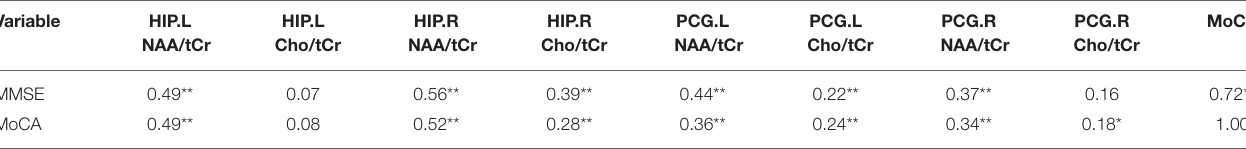
TABLE 3 | The correlation coefficient between cognitive scores and MRS at hippocampus (HIP)/posterior cingulate gyrus (PCG) ( N = 136).